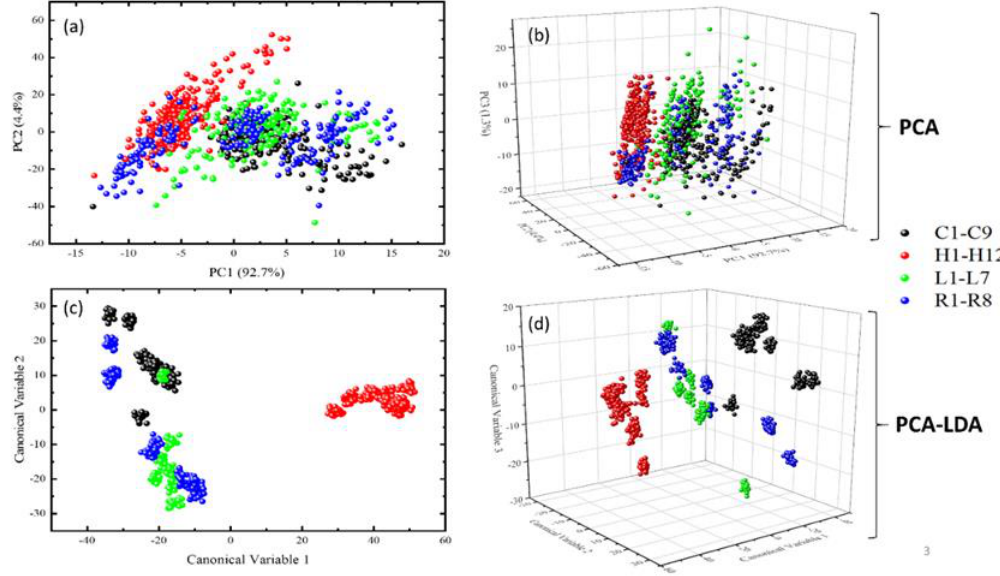
Figure 3. PCA ( a ) 2D and ( b ) 3D score plots and PCA-LDA ( c ) 2D and ( d ) 3D scatter plots corresponding to the olive oil samples from Chania (C), Herakleion (H), Lasithi (L) and Rethymnon (R)